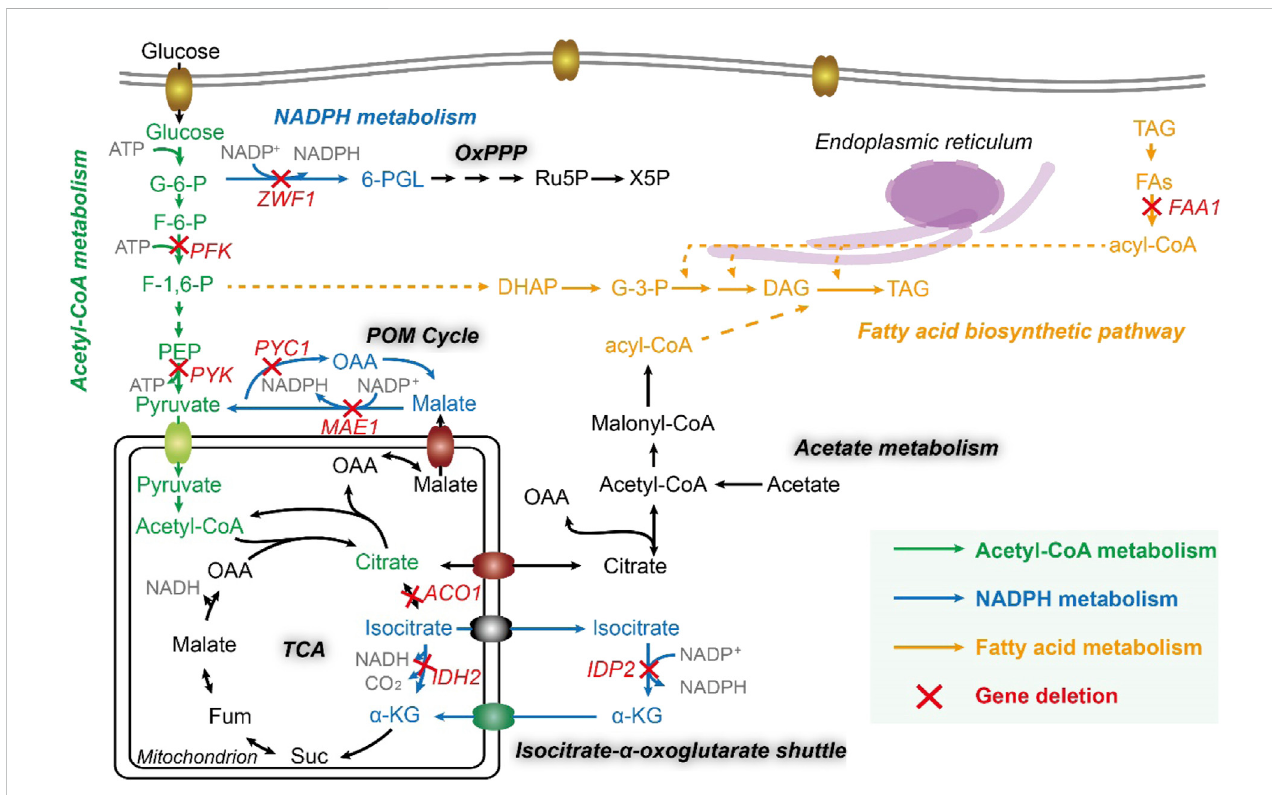
FIGURE 1 The fatty acid metabolic network of Y. lipolytica. FAA1, fatty acyl-CoA synthase; ZWF1, glucose-6-phosphate dehydrogenase; PFK, 6- phosphofructokinase; PYK, pyruvate kinase; PYC1, pyruvate carboxylase; MAE1, malic enzyme; ACO1, Aconitase; IDH2, mitochondrial isocitrate dehydrogenase; IDP2, cytosolic NADP-speci fi c isocitrate dehydrogenase; G-6-P, Glucose-6-phosphate; F-6-P, fructose-6-phosphate; F-1,6-P, fructose- 1,6-diphosphate; PEP, phosphoenolpyruvic acid; OAA, oxaloacetic acid; Fum, fumaric acid; Suc, succinyl coenzyme A; α -KG, 2-oxoglutarate; 6-PGL, 6- phosphogluconolactone; Ru5P, ribulose-5-phosphate; X5P, xylulose-5-phosphate; DHAP, dihydroxyacetone phosphate; G-3-P, glyceraldehyde-3- phosphate; DAG, diacylglycerol; TAG, triacylglycerol; FFA, free fatty acid; PL, phospholipid; Glx, glutamine; QH2, coenzyme